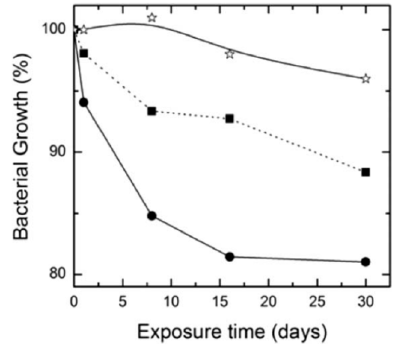
Figure 17. MTT test results showing cell viability of ( A ) murine fibroblasts (L929) and ( B ) human osteosarcoma cell line (Saos-2) cultured on dense PLGA and its nanocomposite films for 24 h, 96 h and 240 h. The error bars were standard deviations.